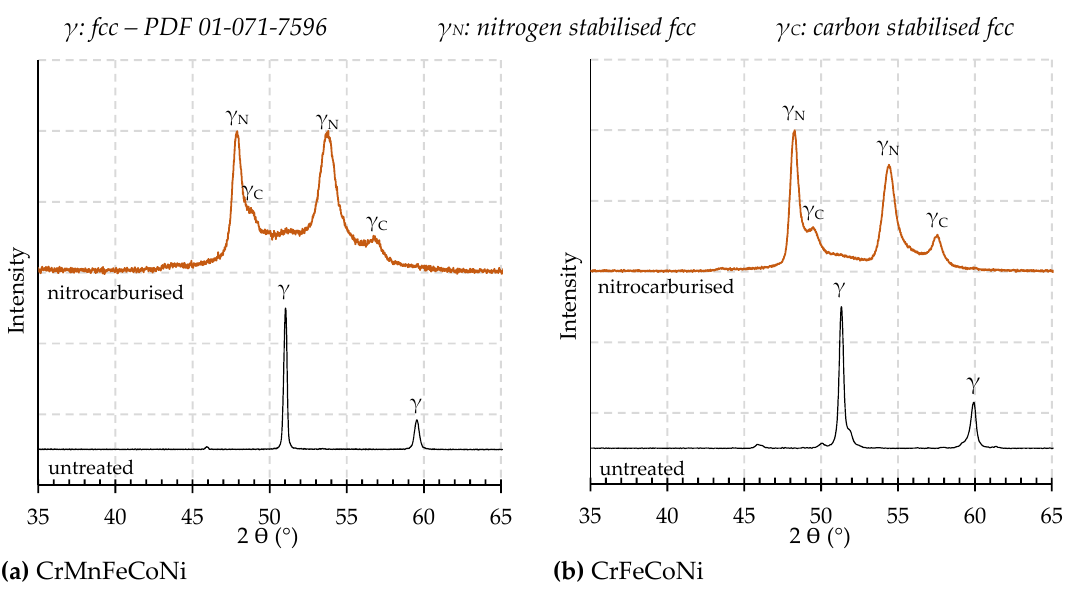
Figure 3. X-ray di ff raction (XRD) di ff ractograms of the as-cast and nitrocarburised CrMnFeCoNi and Figure 3. X-ray diffraction (XRD) diffractograms of the as-cast and nitrocarburised CrMnFeCoNi and CrFeCoNi HEAs. CrFeCoNi HEAs. Table 5. Lattice expansion determined for CrMnFeCoNi and CrFeCoNi depending on the lattice plane and the solved interstitial element (in